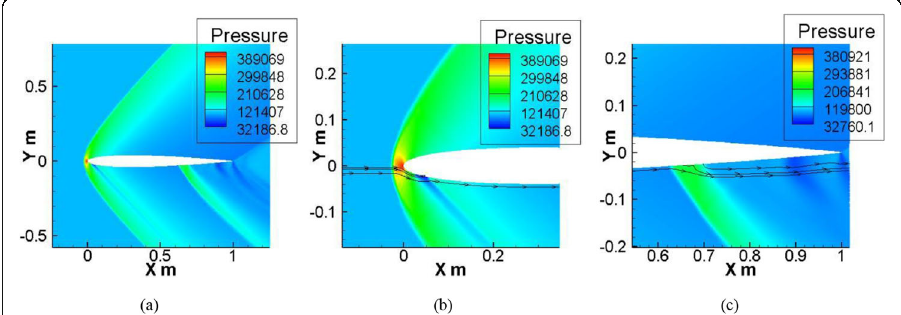
Fig. 14 Computed pressure contours with streamlines at the mass flow rate = 7.5 kg/s. a for the whole optimized NACA0008 airfoil b for the suction slot c for the injection